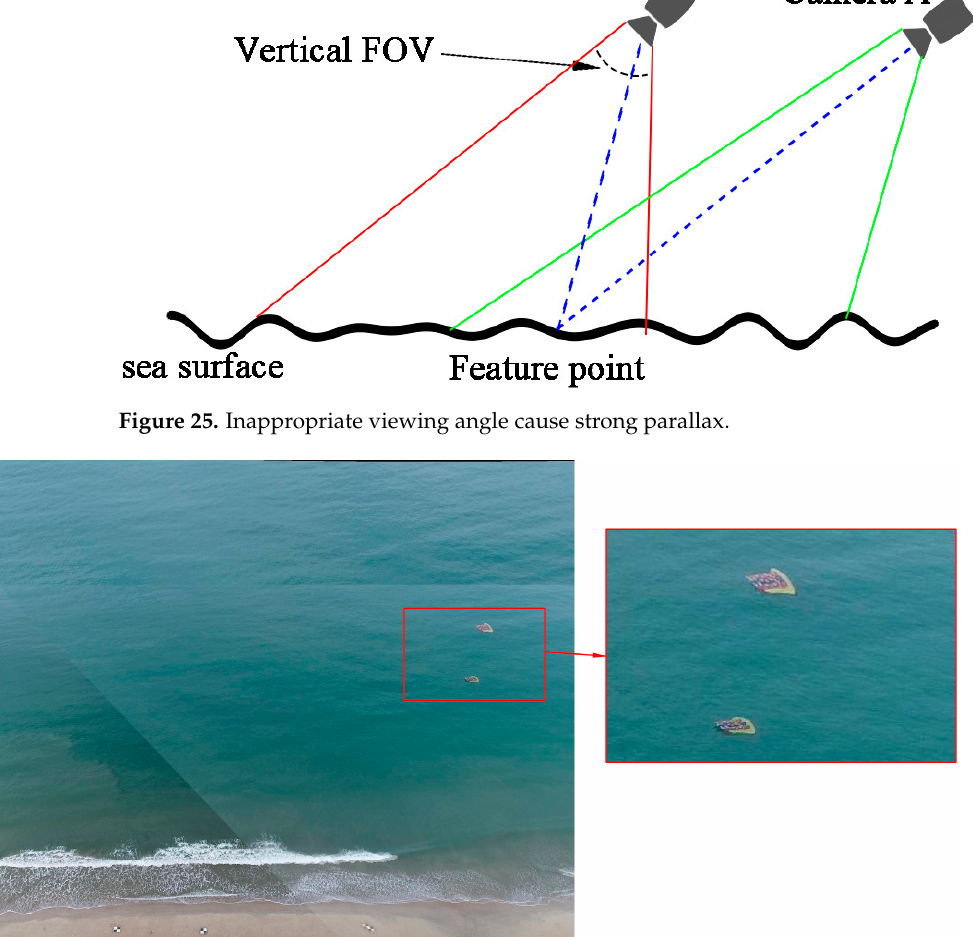
Figure 27. The green rectangle is the FOV of a single UAV. The red is the extension of the stitching. Therefore, it is necessary to continue research related to the development of bathym- etry algorithms based on optical cameras, using photogrammetric techniques based on UAV swarms. Taking into account the optical complexity of waters, one should put for- ward diverse ideas as well as practice experiments to verify theories.